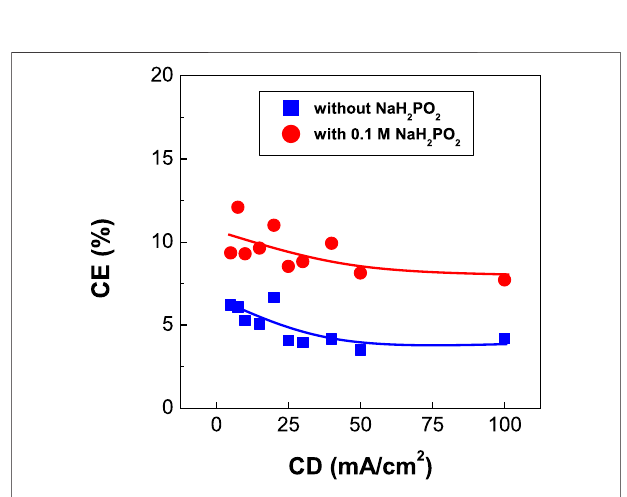
FIGURE 6 | Dependence of current ef fi ciency (CE) of CoPt thin fi lms on currentdensity(CD)(The valuesofCEintheredcurvearesimilar orlowerthan that in Figures 1 , 3